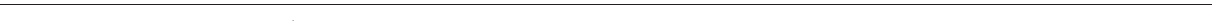
FIGURE 5 | shown are for gated CD3 + T cells. (B) Lymphocytes were isolated from blood and the expression of indicated chemokine receptors on the surface of CD3 + T cells was determined as in (A) . Data shown are for gated CD3 + T cells. (C,D) Total T cells were isolated from ILN (C) and blood lymphocyte (D) . in vitro transwell assay was performed to determine the migratory capacity of T cells toward IP10 and CCL19, which are the ligand for CXCR3 and CCR7, respectively. The chemotaxis index was calculated as mentioned in the Materials and Methods. (E) Total RNA was extracted from the back skin, and the mRNA expression of indicated